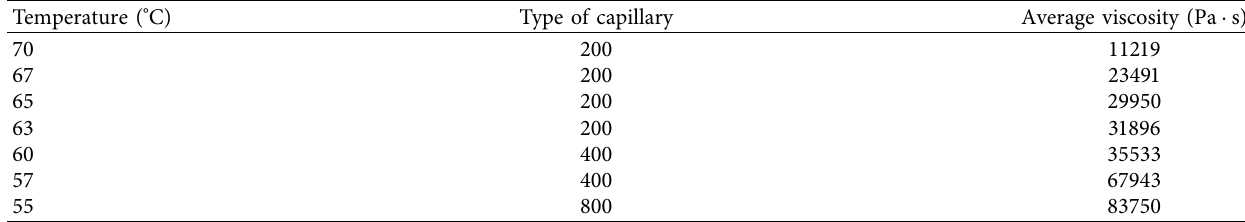
Table 1: Viscosity of SBS-modified asphalt binder at different temperatures.